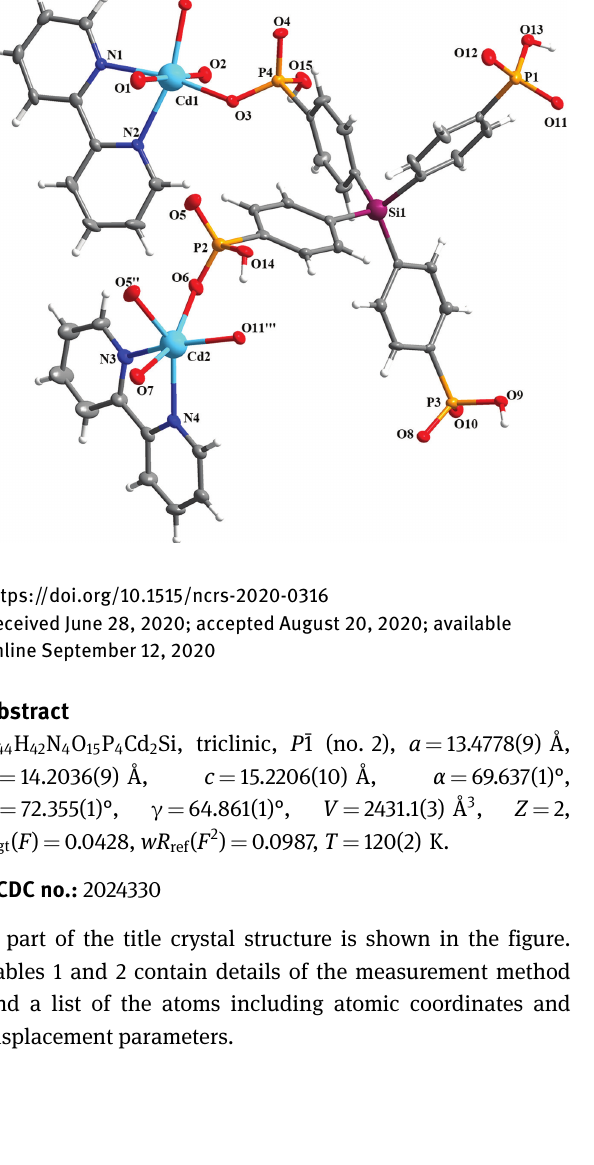
Table 1: Data collection and handling.